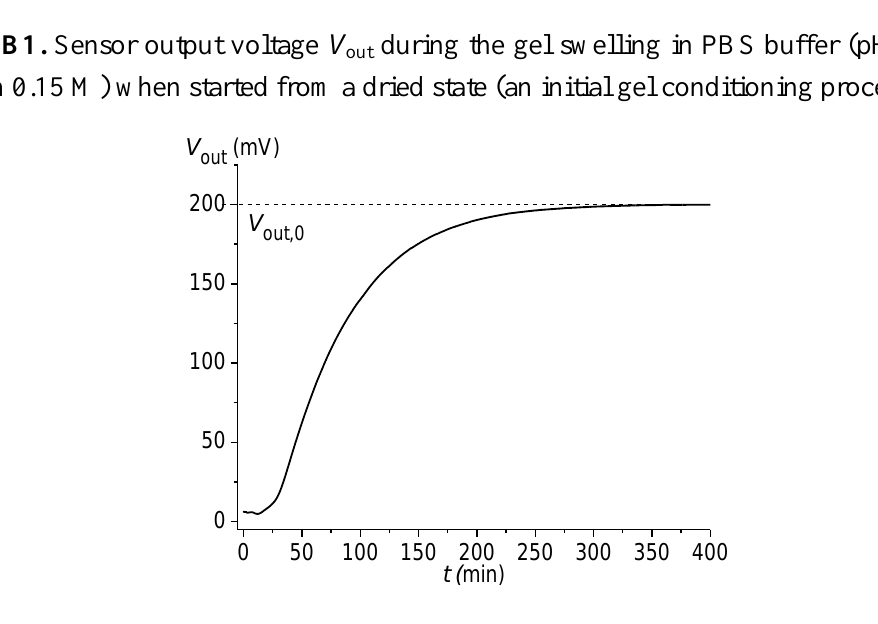
Figure B2. Calibration curve ∆π = f (∆ V